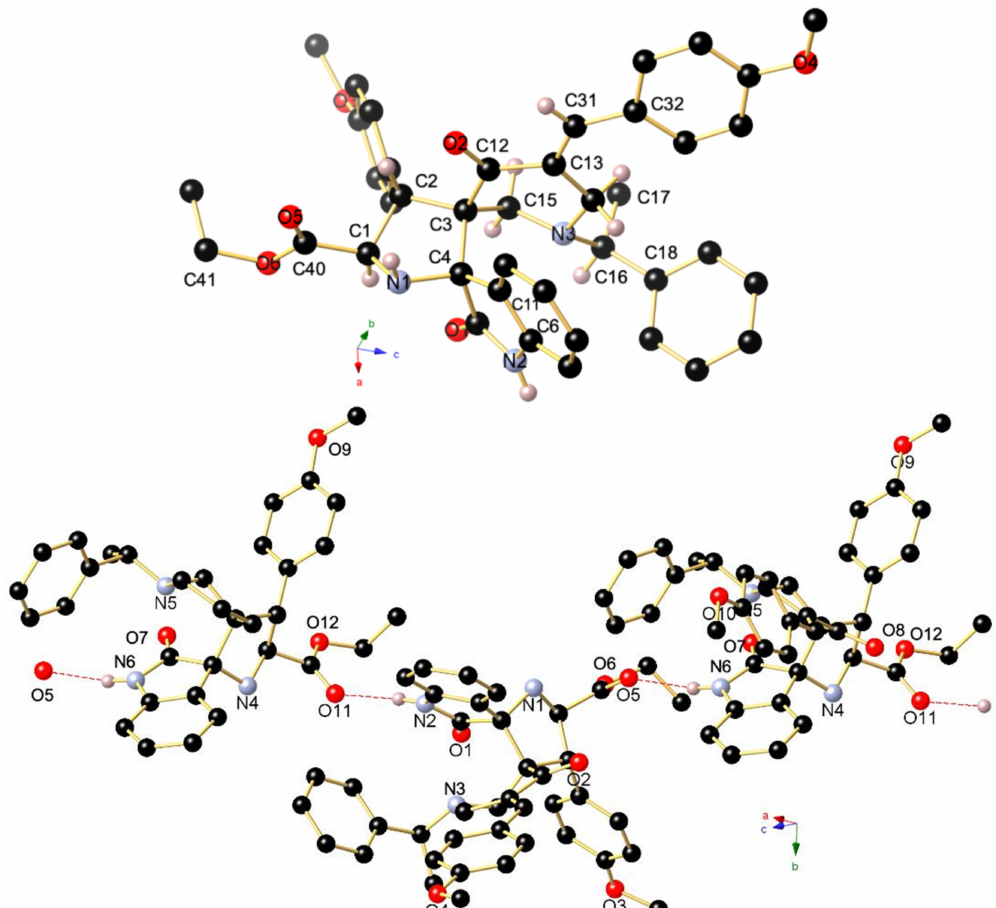
Figure 4. (Top) Ball and Sticks presentation of compound 4c in the crystal. Only stereochemically significant hydrogen atoms are presented. Only one of the two independent molecules in the unit cell is shown. Selected bond lengths (Å) and angles ( ◦ ): C1–N1 1.470(2), N1–C4 1.478(2), C1–C2